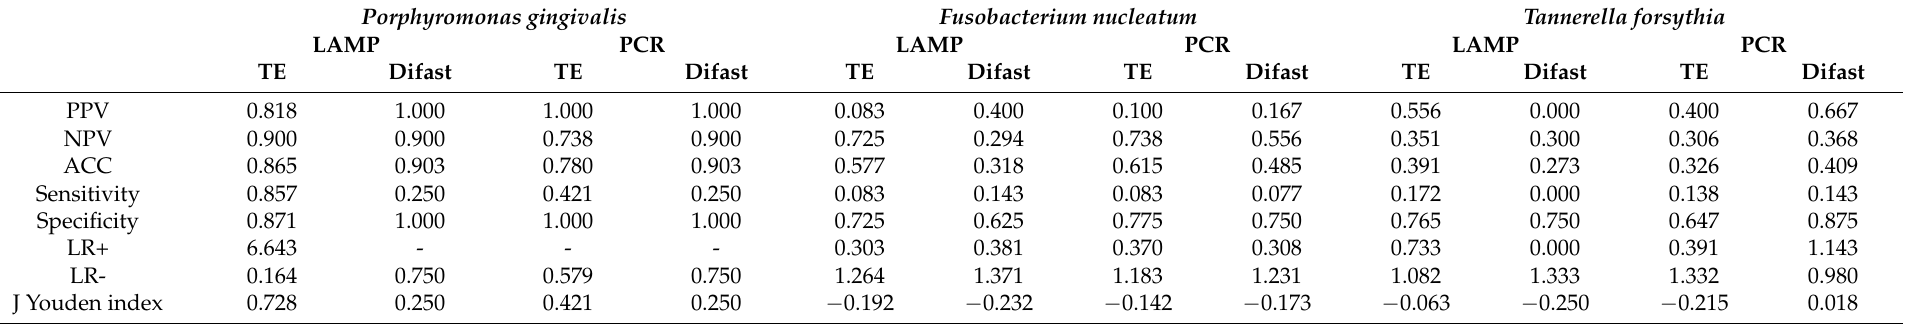
Table 2. Statistical parameters for the periopathogen detection by LAMP and PCR compared with qPCR (as gold standard) depending on the medium (TE or Difast buffer).